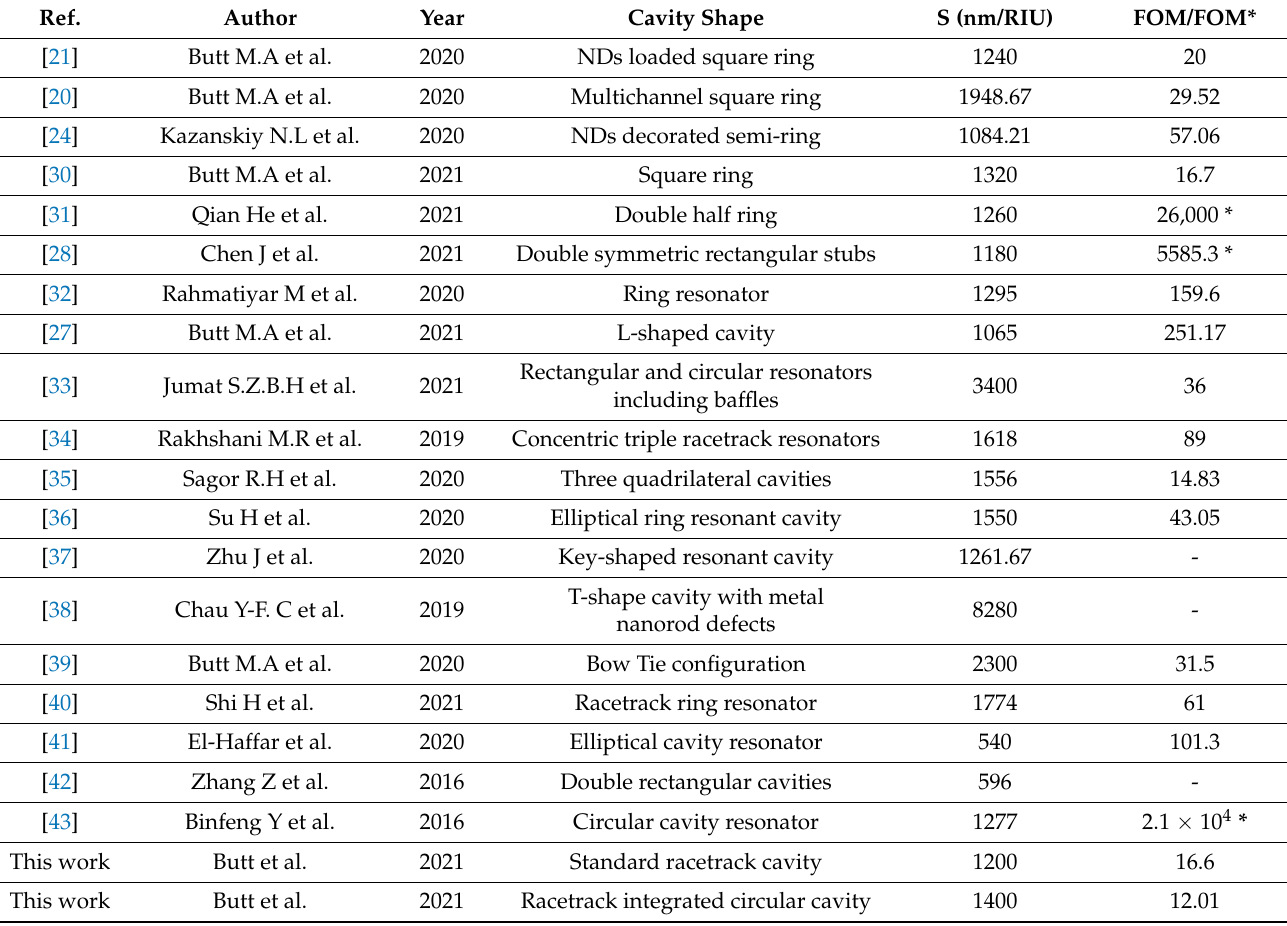
Table 1. Most recent MIM WG plasmonic sensors based on unique cavity designs.